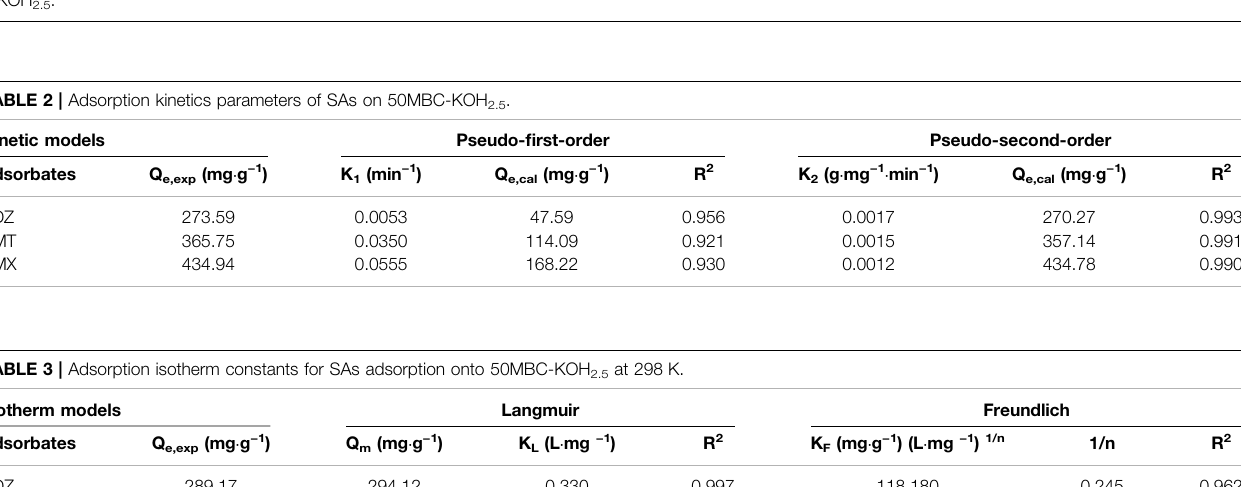
FIGURE3 | (A) Zetapotentialof 50MBC-KOH 2.5 at different pH values and (B) effects ofsolution pH on adsorption capacitiesfor SDZ, SMT and SMX on 50MBC- KOH 2.5 .